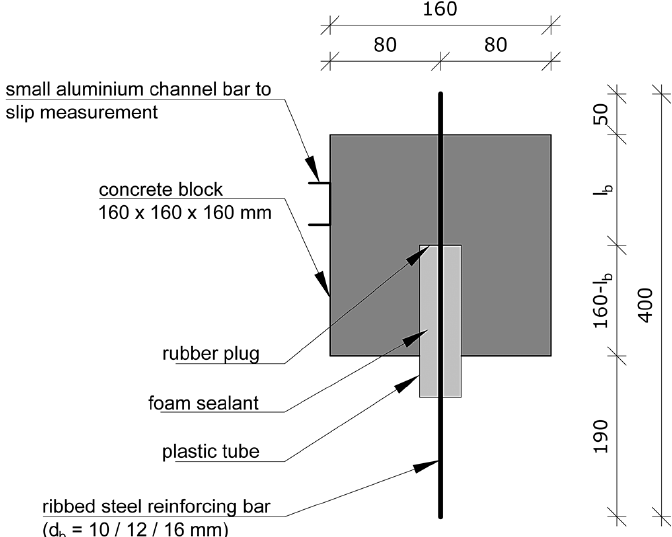
Figure 4. Pull-out test specimen.